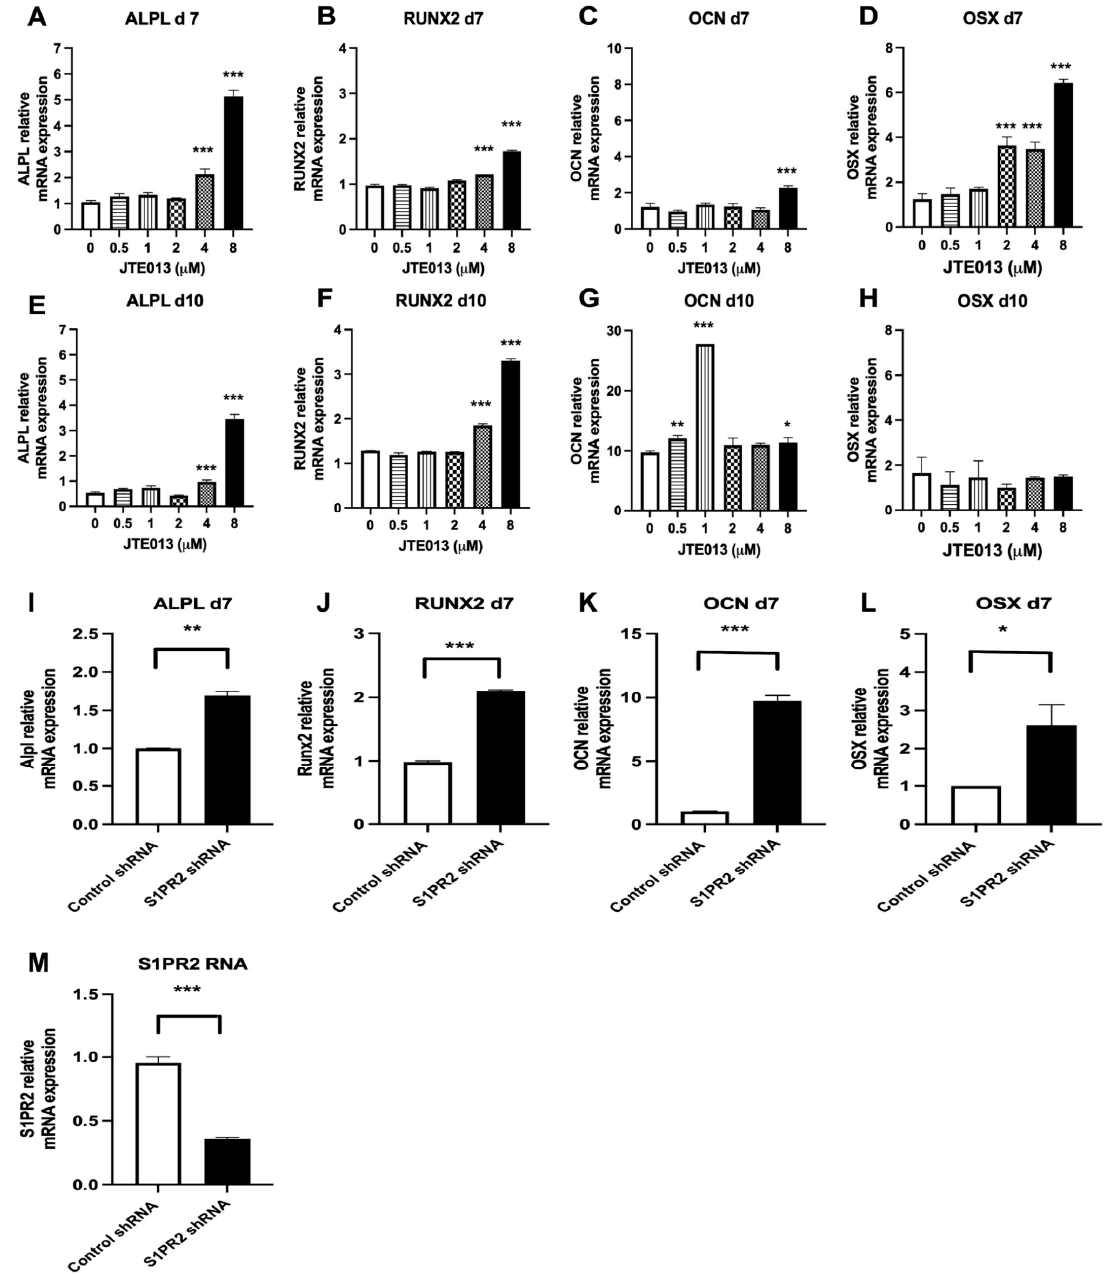
Figure 4. Treatment with the S1PR2 antagonist (JTE013) or a S1PR2 shRNA increased osteogenic gene (ALPL, RUNX2, OCN, and OSX) expressions in murine BMSCs. Murine BMSCs were cultured in osteogenic media with either vehicle (DMSO) or JTE013 (0.5 to 8 μ M) for 7 or 10 days, or were cultured in osteogenic media with a control shRNA or a S1PR2 shRNA for 7 days. ( A , E ) ALPL, ( B , F ) RUNX2, ( C , G ) OCN, and ( D , H ) OSX mRNA levels in murine BMSCs treated with either DMSO or various doses of JTE013 on day 7 or day 10 were quantified by RT-qPCR and normalized by GAPDH expression. ( I ) ALPL, ( J ) RUNX2, ( K ) OCN, ( L ) OSX, and ( M ) S1PR2 mRNA levels in murine BMSCs treated with either a control shRNA or a S1PR2 shRNA on day 7 were quantified by RT-qPCR and normalized by GAPDH expression. (n = 3, * p < 0.05, ** p < 0.01, *** p < 0.001).